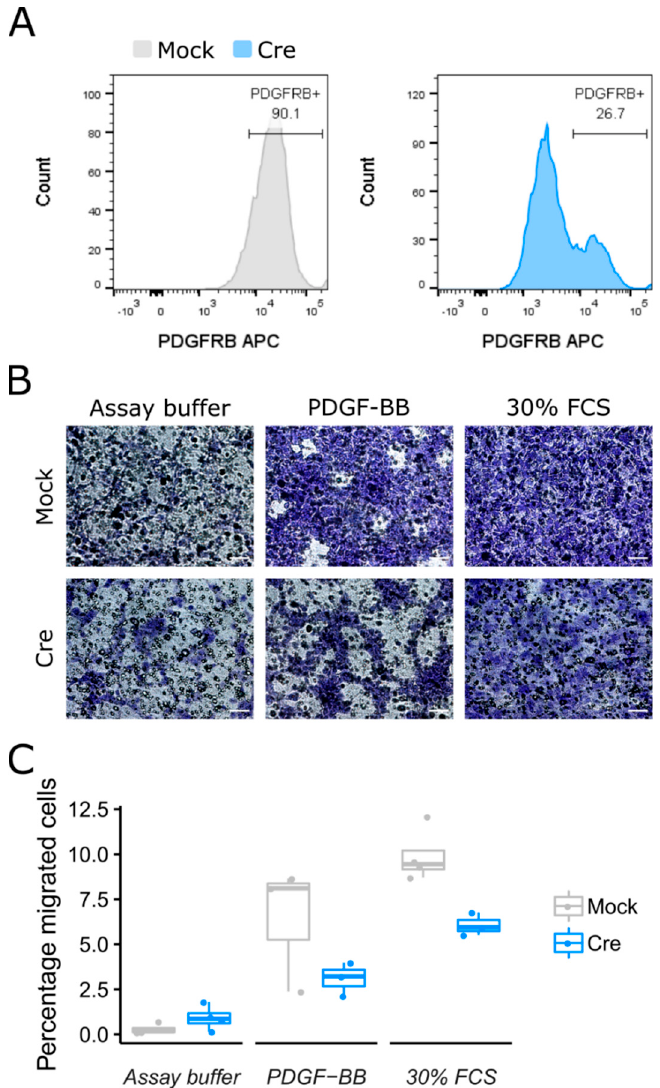
Figure 6. Interstitial stem cells migrate towards PDGF-BB through PDGFRB. ( A ) Flow cytometry analysis for PDGFRB of fibro/adipogenic progenitors isolated from the skeletal muscle of Pdgfrb-flox mice that were transiently transduced with ASLV-Cre or mock. ( B ) Crystal violet staining of transwell assays performed with cells from ( A ). ( C ) Percentage of migrated cells shown in ( B ). n = 3–4 independent wells. Experiments were repeated at least three times, yielding similar results. Scale bar, 50 µm.